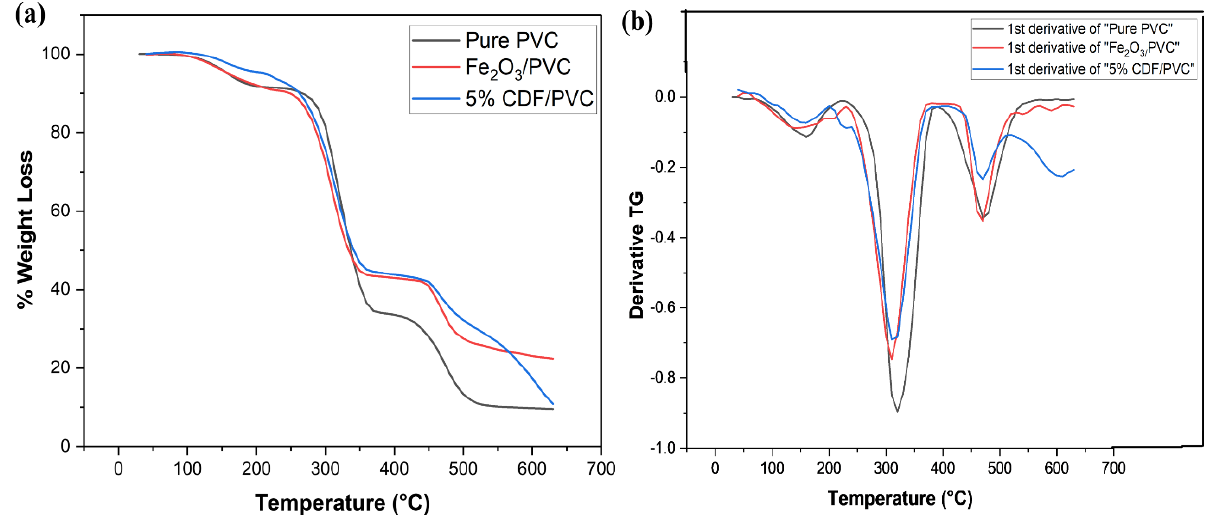
Figure 13. ( a ) A comparison of thermogram of PVC, Fe 2 O 3 , and 5% CDF – PVC, and ( b ) comparison of first derivative of PVC, Fe 2 O 3 – PVC, and 5% CDF –